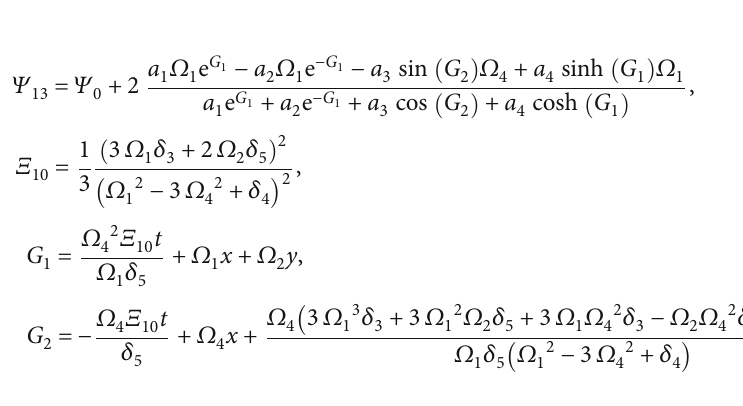
Figure 4: Plot evolution of periodic waves (23) utilizing values a = 2, δ = − 1 : 3, δ 4